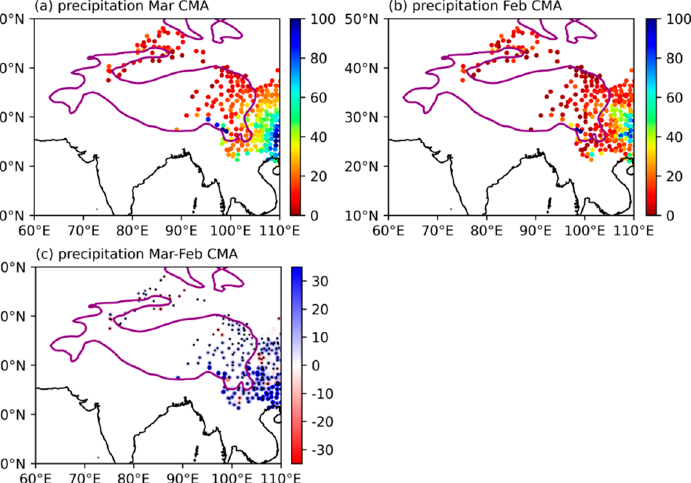
Figure 9. The climatological mean of accumulated precipitation (unit: mm) derived from the China Meteorological Administration in March ( a ) and February ( b ), and their differences ( c ). Dots denote values exceeding the 95% confidence level of Student’s t test. The purple line is the 2000 m elevation contour.